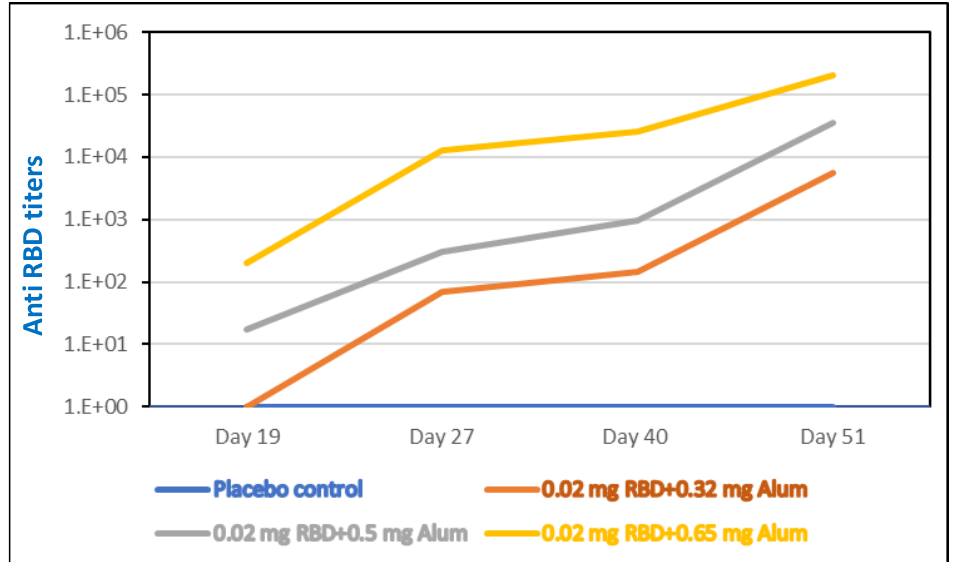
Figure 7. Serum antibody responses against C1-RBD-C-tag antigen in RBD-immunized BALB/c mice. Reciprocal end-point titers of anti-RBD-C-tag immunoglobulin antibody in sera from BALB/c mice immunized subcutaneously with 20 µg RBD-C-tag antigen per mouse, adjuvanted with either 320 µg, 500 µg, or 650 µg Alhydrogel ® ‘85’ representing Alhydrogel ® ‘85’/RBD-C-tag, adjuvant:antigen ratios of 16:1, 25:1 and 32:1 (w/w), respectively. Titer values of peripheral blood sera were collected at days 19, 27, 40 and 51.